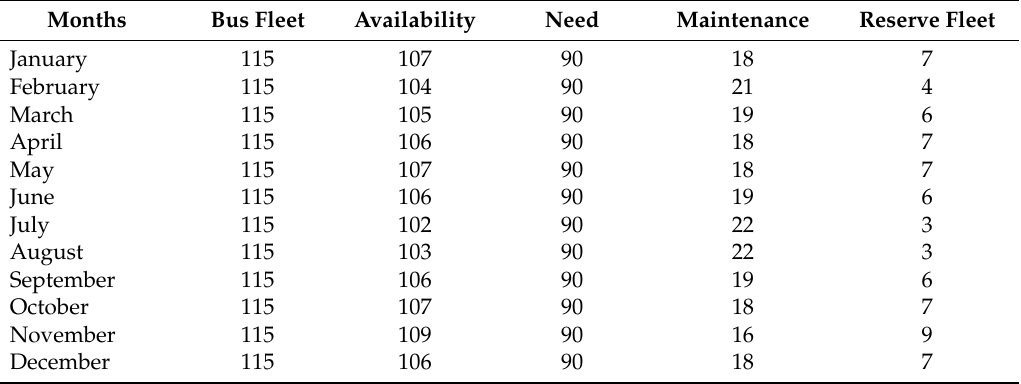
Table 5. Availability versus Need for buses—Systematic preventive